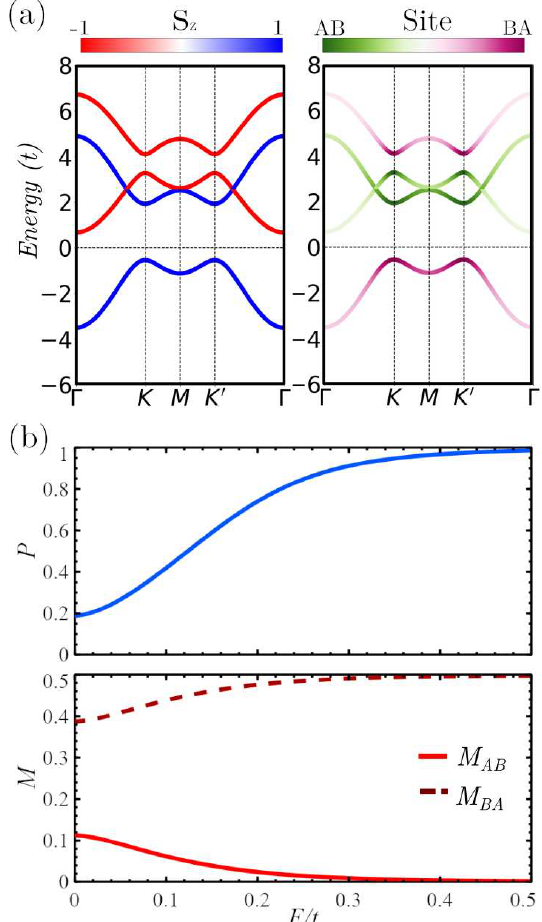
Figure 3: Calculations in the multiferroic regime at U / t = 6 and V / t = 1.5. (a) Band structure, the colormaps represent the eigenvalue of the operator: s in the left (right) panel. A spin polarized and sublattice situation can be identified. (b) Magnetoelectric coupling analysis. Evolution of the order parameters P (top panel) and M (bottom panel) as a function of an external electric field in the z - direction. Due to the strong magnetoelectric coupling, both the electric polarization and the ferrimagnetic order are controlled with the external electric field. The orders saturate at E / t =